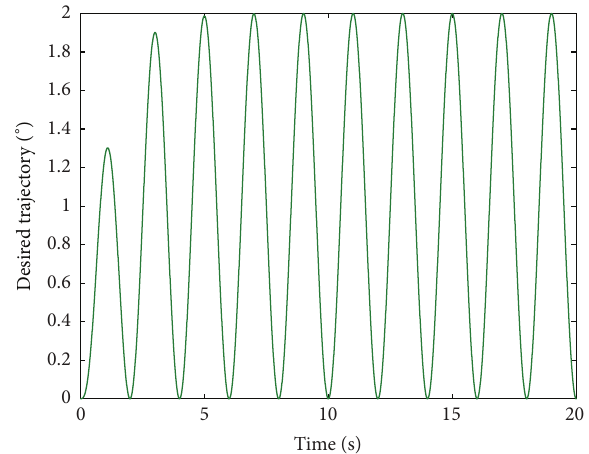
Figure 10: The desired trajectory (slow case).